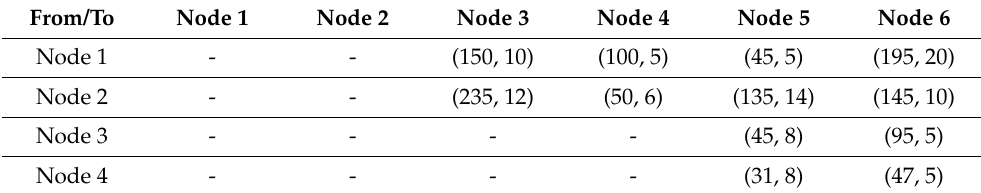
Table 5. Ordering behavior of nodes in Topology 1.